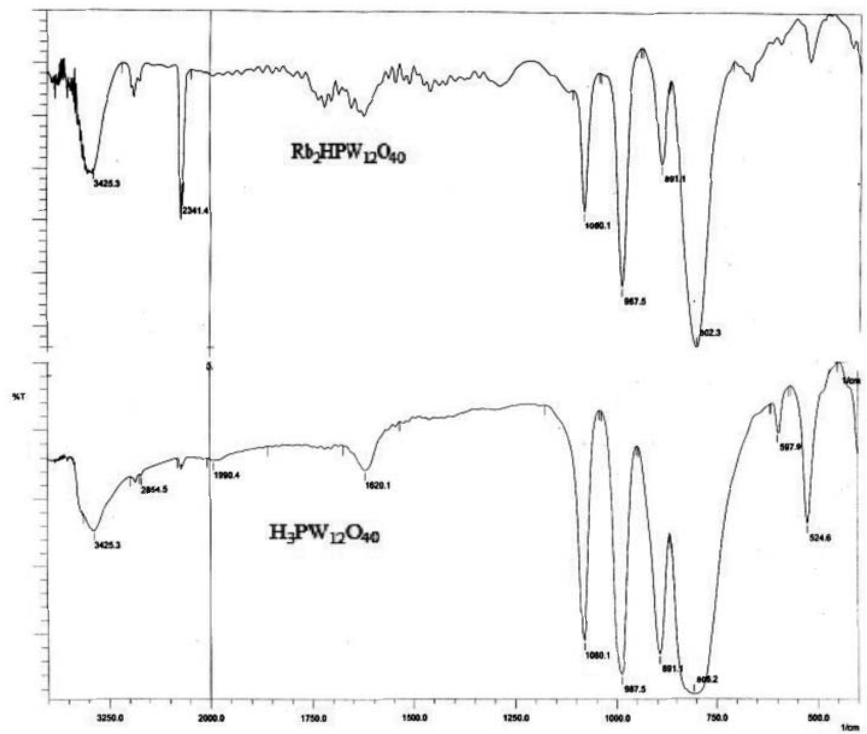
Fig. 1. FT-IR spectrum of H